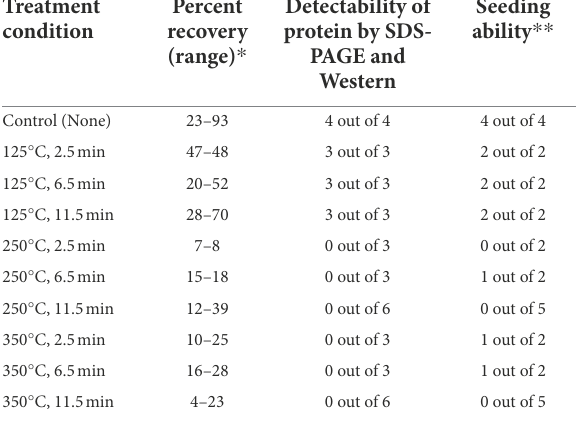
TABLE 1 Summary of analysis of Sup35NM-His 6 aggregates recovered from stainless